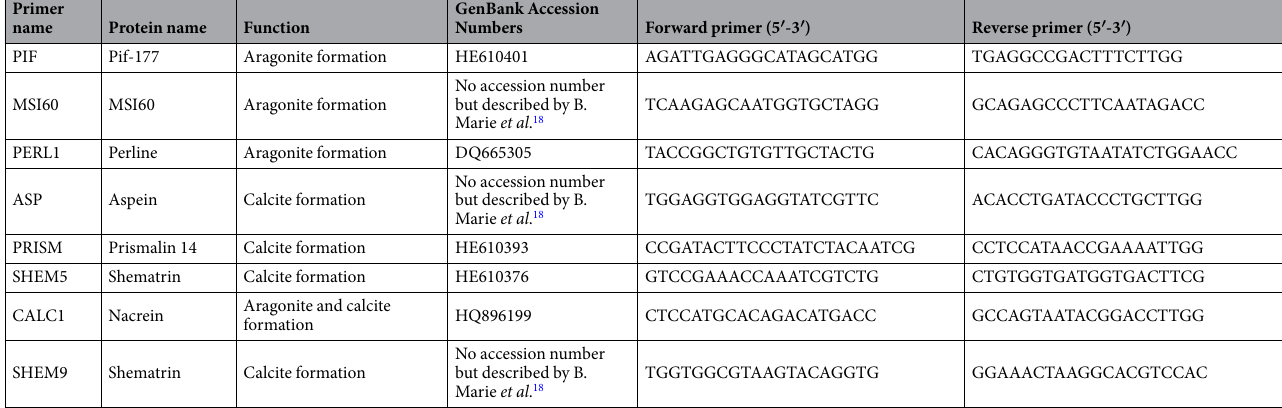
No accession number but described by B.